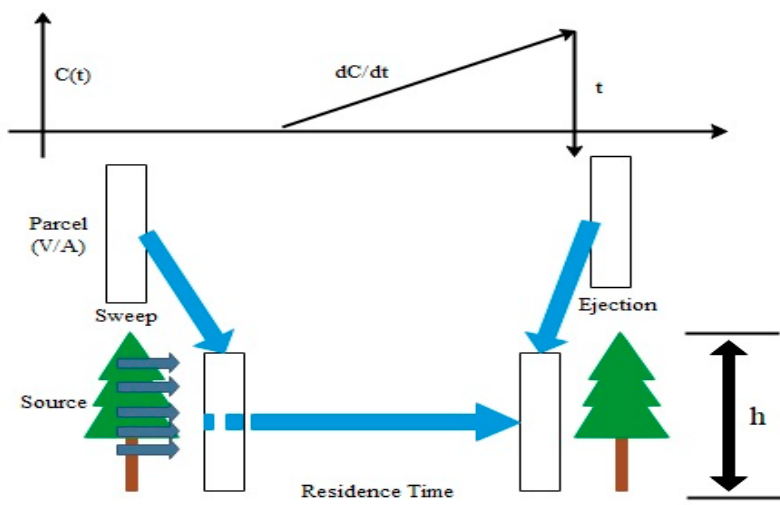
Figure 2. The concept of the surface renewal theory.